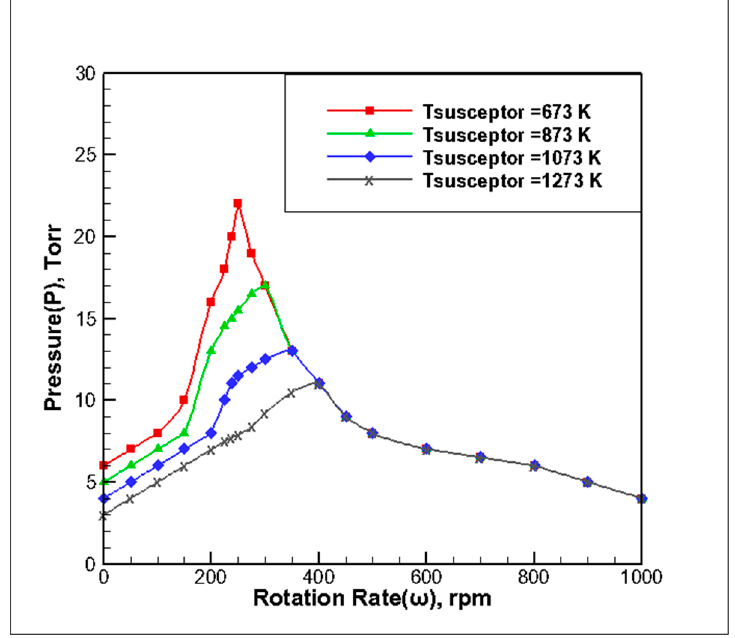
Figure 5. Stability map of P- ω at different substrate growth temperatures.